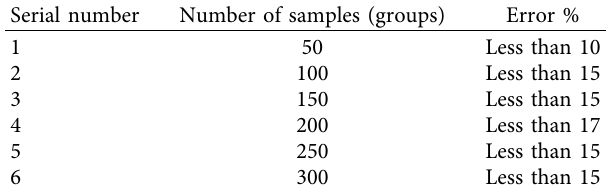
Table 5: Error percentages of different test samples.